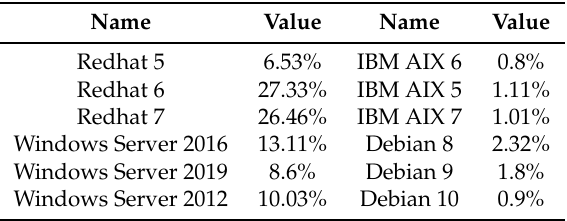
Table 2. Distribution of vulnerabilities with operating systems division.